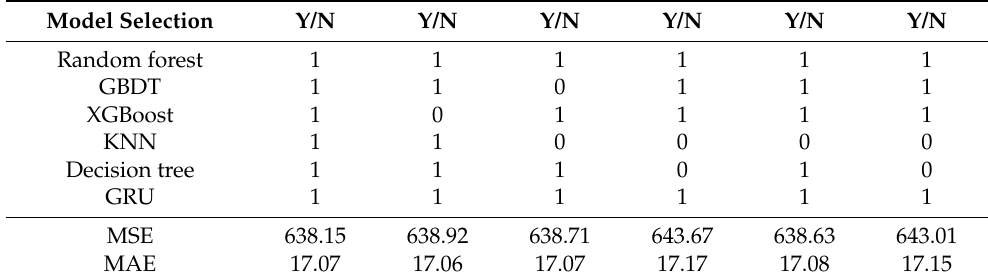
Table 4. The model selection analysis table.